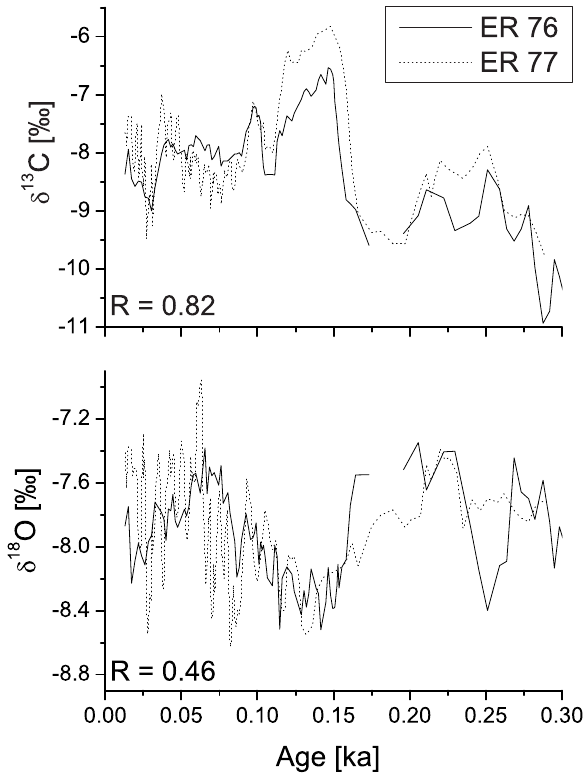
Fig. 5. Comparison of the δ 13 C and δ 18 O profiles of ER 76 (solid line) and ER 77 (dotted line) for the last 300a. The age models of both stalagmites are based on lamina counting (Frisia et al., 2003). Around 1700AD both stalagmites show a hiatus (ER 76: ∼ 50a, ER77: ∼ 100a, Frisia et al., 2003), and the subsequent laminae are very thin (i.e., between 10 and 30µm). This precludes a direct com- parison of the older parts of the